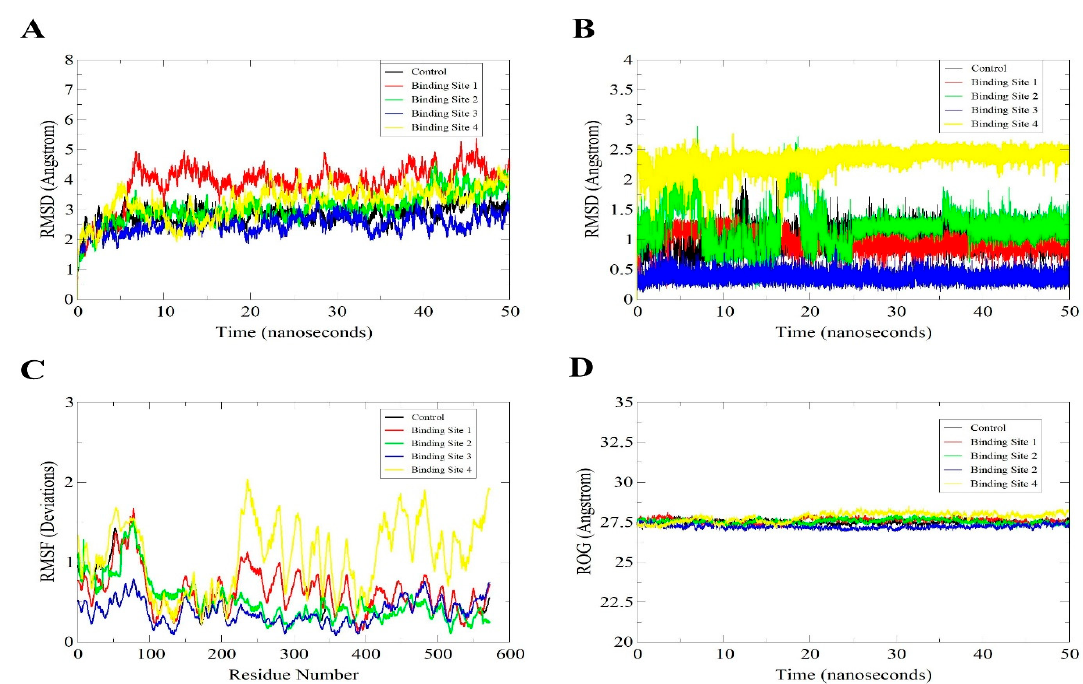
Figure 7. MD simulation-based analysis of structural and stability complexes. ( A ). Enzyme RMSD analysis, ( B ). Ligand RMSD analysis, ( C ), Enzyme RMSF analysis and ( D ), Enzyme ROG analysis.